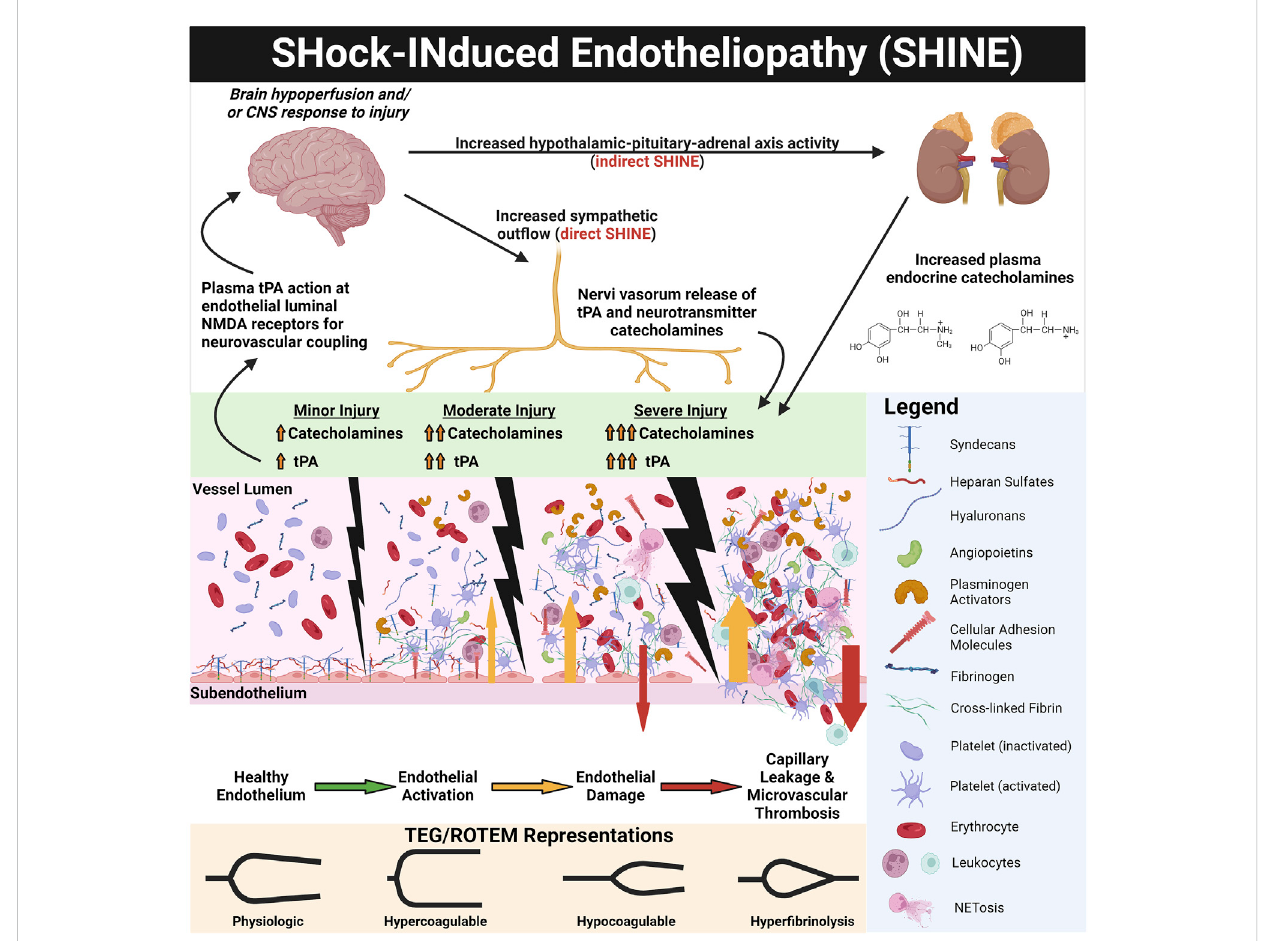
FIGURE 3 SHock-INducedEndotheliopathy(SHINE)as aRe fl ectionofInjury Severity. Increasingsympatho-adrenal activation withincreasinginjury andshock severity leads to endothelial activation and damage. Increased sympathetic out fl ow directly provokes SHINE via perivascular sympathetic nerve exocytosis of neurotransmitter catecholamines and enzymatically active tissue plasminogen activator (tPA) into the vessel walls and directly into the microvasculature (O ’ Rourke et al., 2005; Kwaan, 2014). Hypothalamic-pituitary-adrenal axis activity also increases circulating plasma catecholamines. The corresponding endothelial and hemostatic changes are dose-dependent to injury/shock severity, as measured by endothelial biomarkers (e.g., plasma syndecan-1 and soluble thrombomodulin) and on thromboelastography (TEG) and rotational thromboelastometry (ROTEM) tracings.Forexample,withtrauma,TEG/ROTEMtracingsprogressfromphysiologichemostasistohypercoagulableinmildtrauma,tohypocoagulablein moderate trauma, and fi nally hyper fi brinolytic in severe trauma(Johansson and Ostrowski, 2010). Genetically preserved responses to critically ill patients in fl icted by trauma, burns, and sepsis are similar, suggesting early responses to shock are evolutionarily preserved wherein SHINE may be a unifying mechanism (Xiao et al., 2011; Johansson et al., 2017a). The catecholaminergic surge (in particular the vasoconstrictive action of norepinephrine) causes glycocalyx shedding, endothelial injury, and de-endothelialization of perfused vessels (Dolgov et al., 1984; Makhmudov et al., 1985; Kristová et al., 1993; Vischer and Wollheim, 1997). The activated/injured endothelium promotes thrombosis, causing occlusion of the microvasculature. Together with capillary leak, perivascular edema, and vasoconstriction, these vascular responses provoke a cycle of progressive tissue hypoperfusion, hypovolemia, organinjury,andincreasingsympatho-adrenalactivation(OpalandVanDerPoll,2015;Johanssonetal.,2017a).Ithasbeenhypothesizedthattheensuing hypocoagulabilityandhyper fi brinolysismaybeacompensatorycounterbalancetothepro-thromboticendotheliuminanattempttomaintainpatencyof the microvasculature (Johansson and Ostrowski, 2010). Therefore, the two major hemostatic compartments — the endothelium and the blood — may “ switch ” phenotypes in some progressing shock states. Whereby the physiologic endothelium acts as anti-thrombogenic surface to oppose coagulable blood,inshock,therolesmayswitchtoapro-thromboticendotheliumwithahypocoagulable/hyper fi brinolyticbloodphenotypeinattempttorebalance hemostasis, decrease the blood viscosity, and restore perfusion (Johansson and Ostrowski, 2010) (see Figure 4). Not only does tPA exert pro- fi brinolytic activity via enzymatic activation of plasminogen, but tPA in the brain uniquely acts as a signaling agonist on the N-Methyl-D-Aspartate (NMDA) receptor on the endothelial luminal surface of small cerebrovascular arterioles. The activated NMDA receptor increases synthesis of nitric oxide to cause vasodilation and increase cerebral blood fl ow (Su et al., 2009; Haile et al., 2012; Yepes, 2015). Thus, increased free tPA (that is, free from complexes with PAI-1 and other inhibitors) in shock states may simultaneously increase systemic perfusion via fi brinolysis of occlusive thrombi and as a neurovascular coupling agent to increase cerebral blood fl ow (Su et al., 2009; Yepes, 2015). Created with